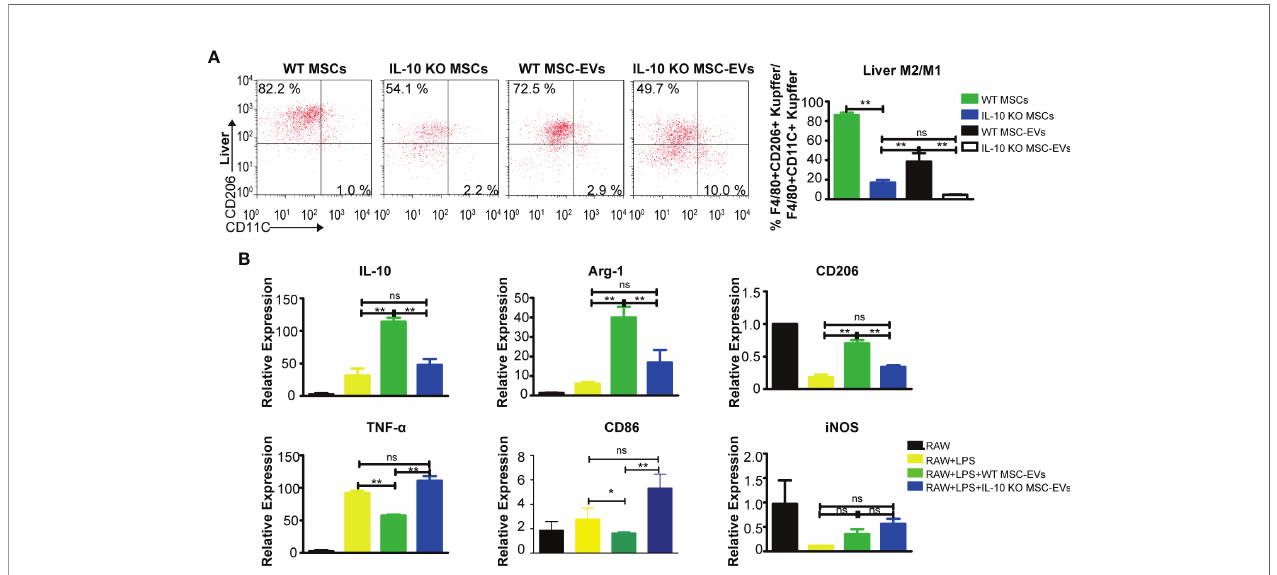
FIGURE 5 | WT MSC-EVs promote the anti-in fl ammatory polarization of macrophages. (A) Flow cytometry analysis of the proportion of CD45 + CD11b + F4/ 80 + CD11C + and CD45 + CD11b + F4/80 + CD206 + cells in liver tissues from THS mice treated with the indicated MSCs (5×10 5 ) or EVs (20 m g) (n=3 – 5). (B) RAW264.7 cells pretreated with 100 ng/ml LPS for 12 h were exposed to the indicated EVs (20 m g) for another 12 h The mRNA levels of pro-in fl ammatory markers (TNF- a , CD86, CD11C) and anti-in fl ammatory markers (IL-10, CD206, Arg-1) were detected by RT-PCR. *P < 0.05, **P < 0.01; ns, not signi fi cant. There were three samples (individual biological sample) in each group. All data are shown as the means ±